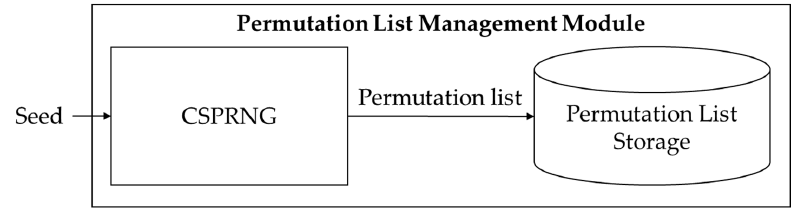
Figure 6. Permutation list management module structure and flows.